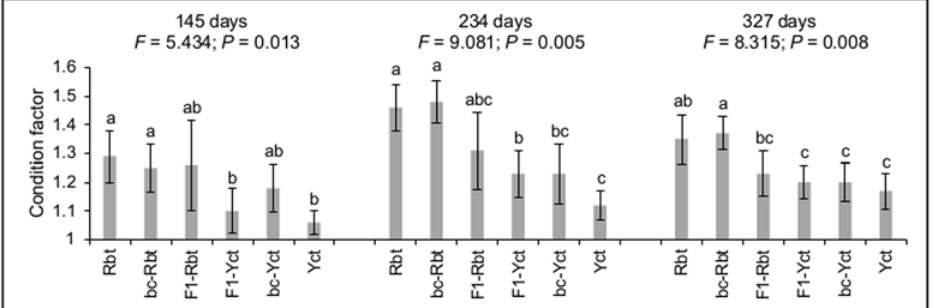
Fig 1. Mean condition factor ( ± SD) for each cross at each time point (145, 234, and 327 days post- fertilization). Results from PERMANOVA tests are shown (pseudo- F and P -value) and lowercase letters indicate significant differences ( P < 0.05) in condition factor between crosses in post-hoc tests. Rbt = rainbow trout, bc-Rbt = first generation Rbt backcross (Rbt x F1), F1-Rbt = F1 hybrid with Rbt maternal